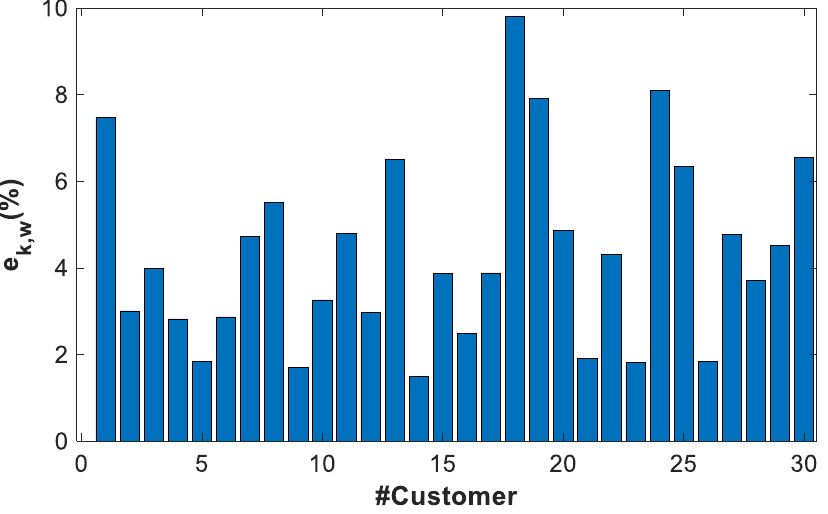
Figure 9. The partial residual of the power profiles estimator, 𝑌 𝐴𝐴𝐴𝐴−𝐵𝐴 ̂ , of sub cluster k = AAAA-BA. The residual is normalized by the contractual power of the cluster AAAA-BA (P AAAA-BA = 4 kW).